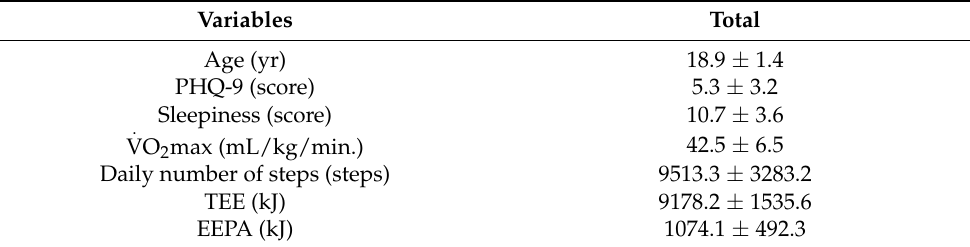
Table 1. Characteristics of study subjects.